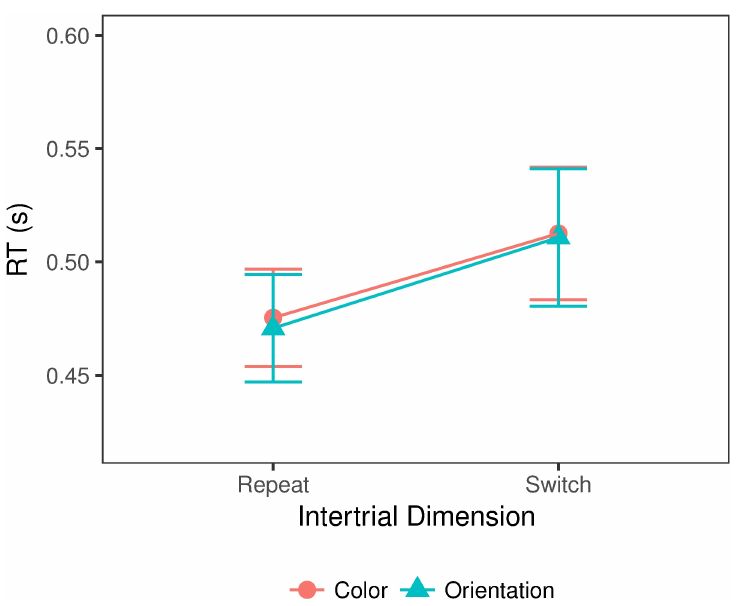
Fig 5. Dimension repetition/switch effect in Experiment 3. Mean RTs were significantly faster when the target- defining dimension was repeated. Error bars show the standard error of the mean.